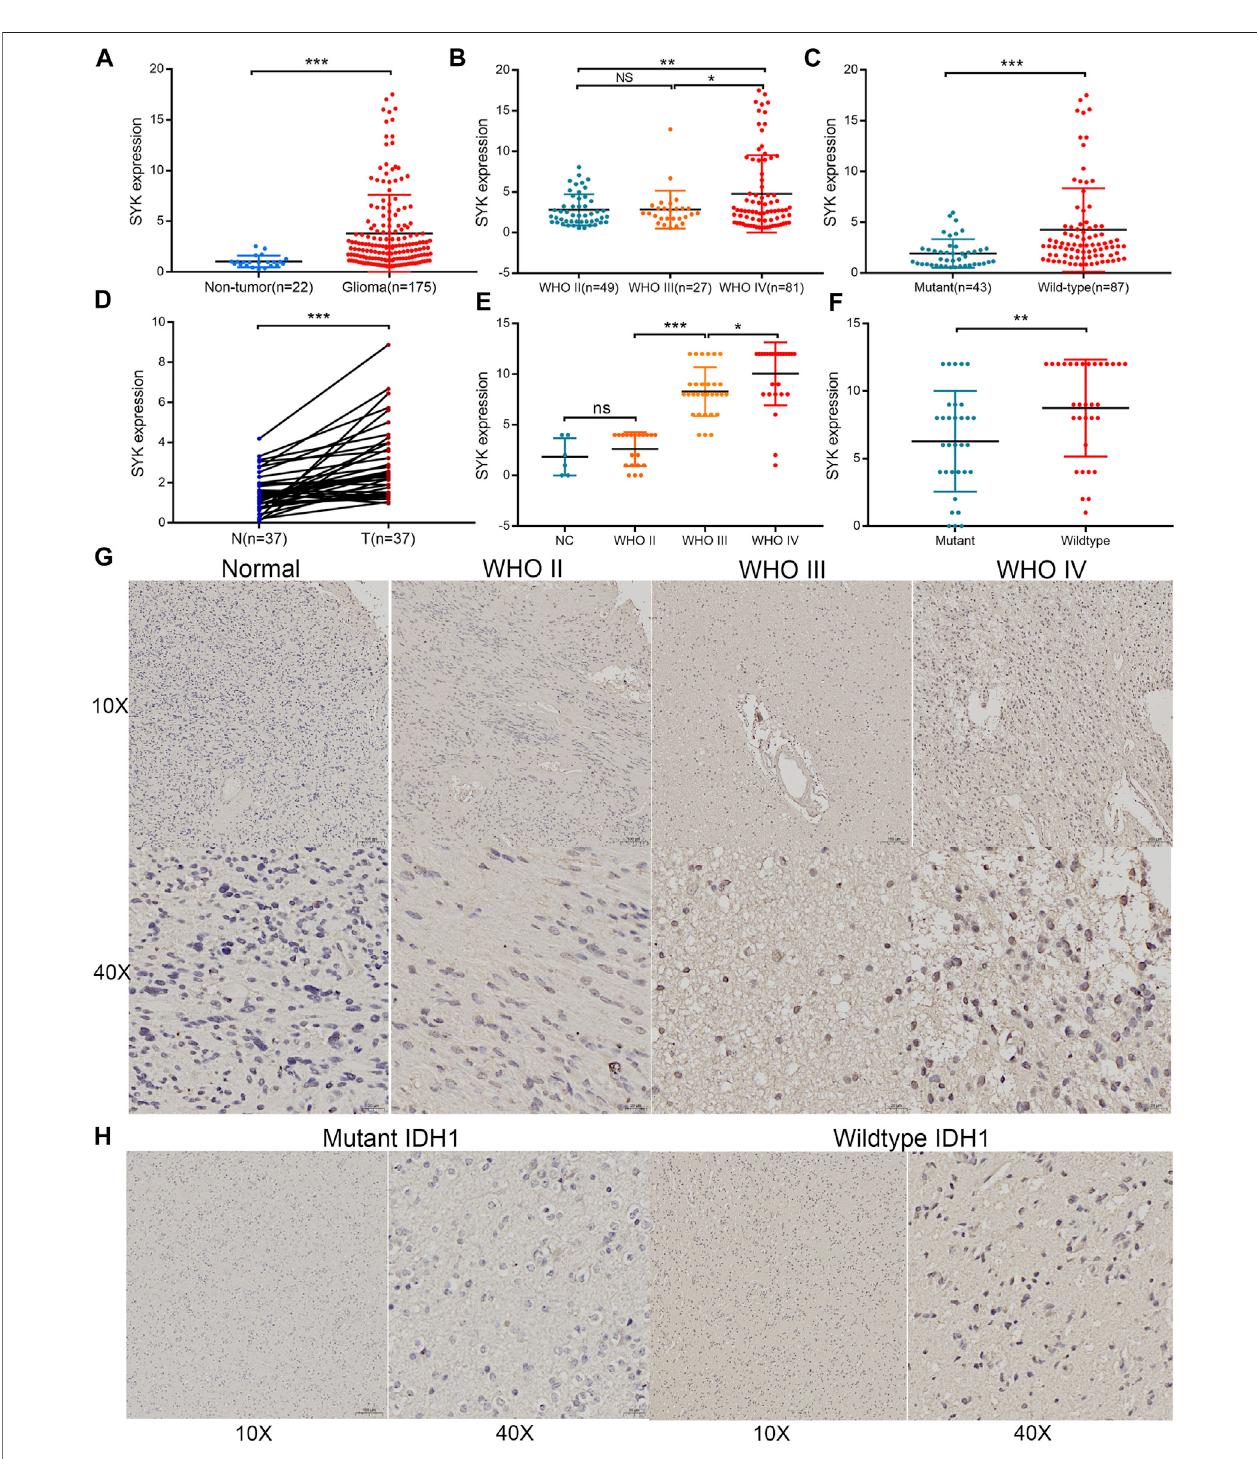
FIGURE 2 | Validation of the expression pattern of SYK in diffuse gliomas analyzed by RT-qPCR and IHC. (A) The expression of SYK in diffuse glioma and normal brain tissues analyzed by RT-qPCR; (B) The expression of SYK in diffuse glioma with different WHO grades analyzed by RT-qPCR; (C) The expression of SYK in diffuse glioma with wildtype and mutant IDH1 analyzed by RT-qPCR; (D) The expression of SYK in diffuse glioma with glioma and peritumoral tissues analyzed by RT-qPCR; (E – H) The expression level of SYK in diffuse glioma with different WHO grades (E,G) and wild-type and mutant IDH1 (F,H) analyzed by IHC staining. p < 0.05 was considered signi fi